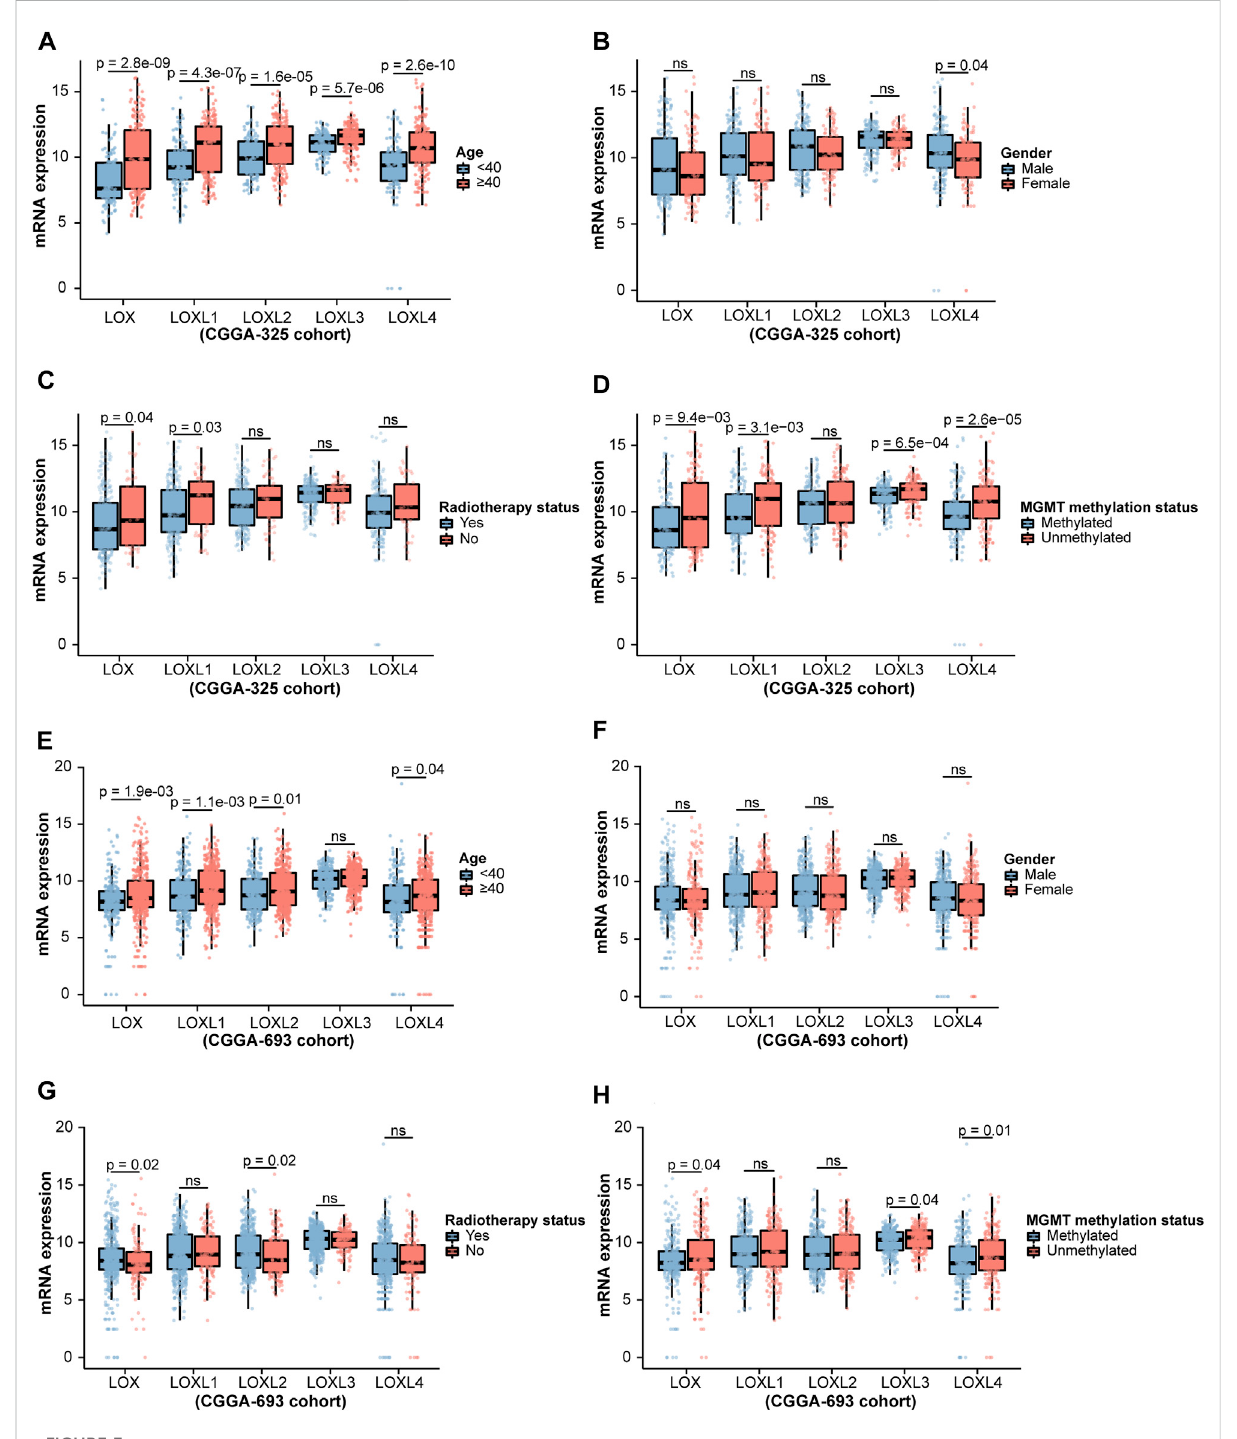
FIGURE 3 Analysis of relationship between LOXs expressions and age, gender, radiotherapy status or MGMT methylation status in glioma in CGGA-325 and CGGA-693 cohorts. (A – D) Indicates the statistical signi fi cance of LOXs mRNA expressions in glioma patients according to strati fi ed analysis by age, gender, radiotherapy status or MGMT methylation status in CGGA-325; (E – H) alidation of mRNA expressions of LOXs in glioma patients strati fi ed by age, gender, radiotherapy status or MGMT methylation status in